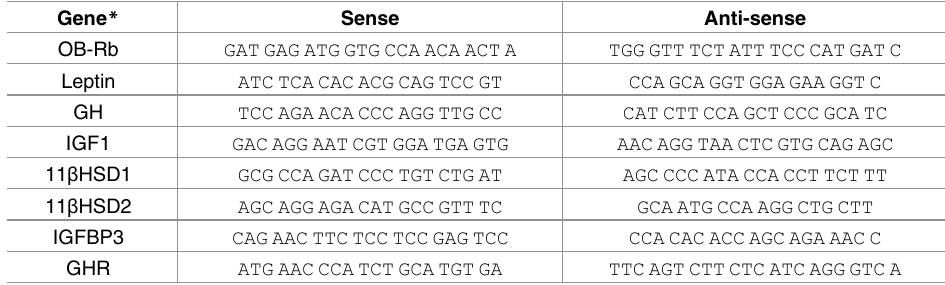
* Leptin receptor (OB-Rb), growth hormone (GH), insulin-likegrowth factor-1 (IGF1), 11 β -hydroxysteroid dehydrogenase-1 (11 β HSD1), 11 β -hydroxysteroid dehydrogenase-2 (11 β HSD2), growth hormone receptor (GHR), insulin-likegrowth factor binding protein-3